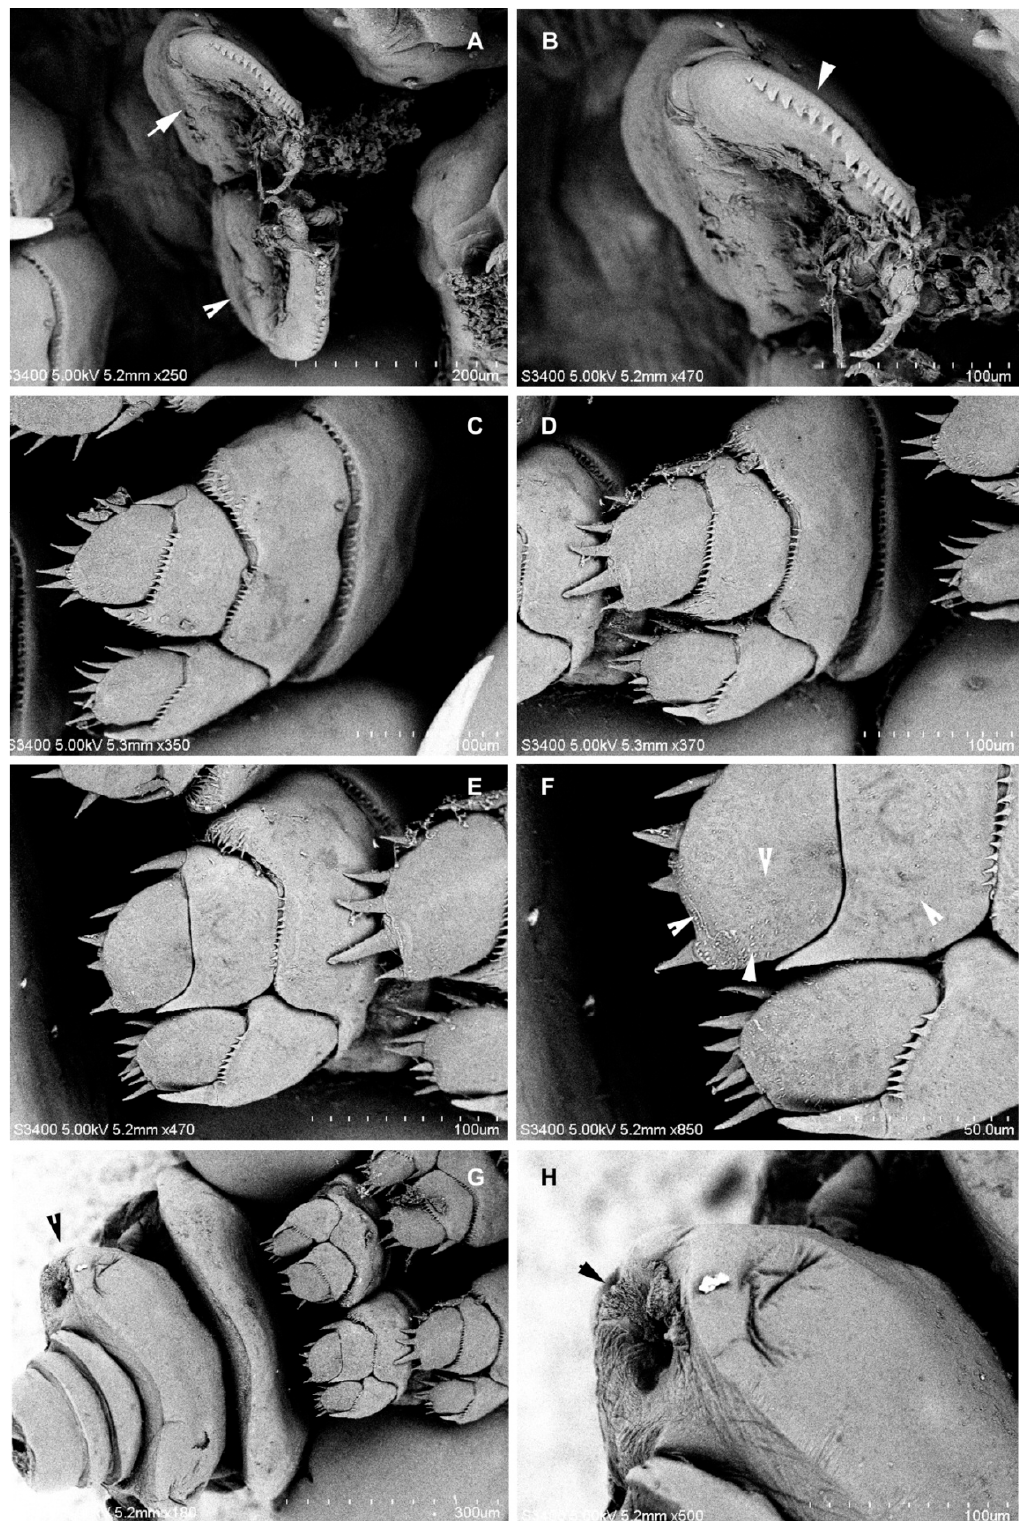
Figure 6. Nemesis santhadevii sp. nov. from Atelomycterus marmoratus , ovigerous female. ( A ) leg 1, right and left (arrows); ( B ) leg 1, high magnification (arrow showing denticles); ( C ) leg 2; ( D ) leg 3; ( E ) leg 4; ( F ) leg 4, high magnification (arrow showing spinules); and ( G , H ) genital double somite (arrow).